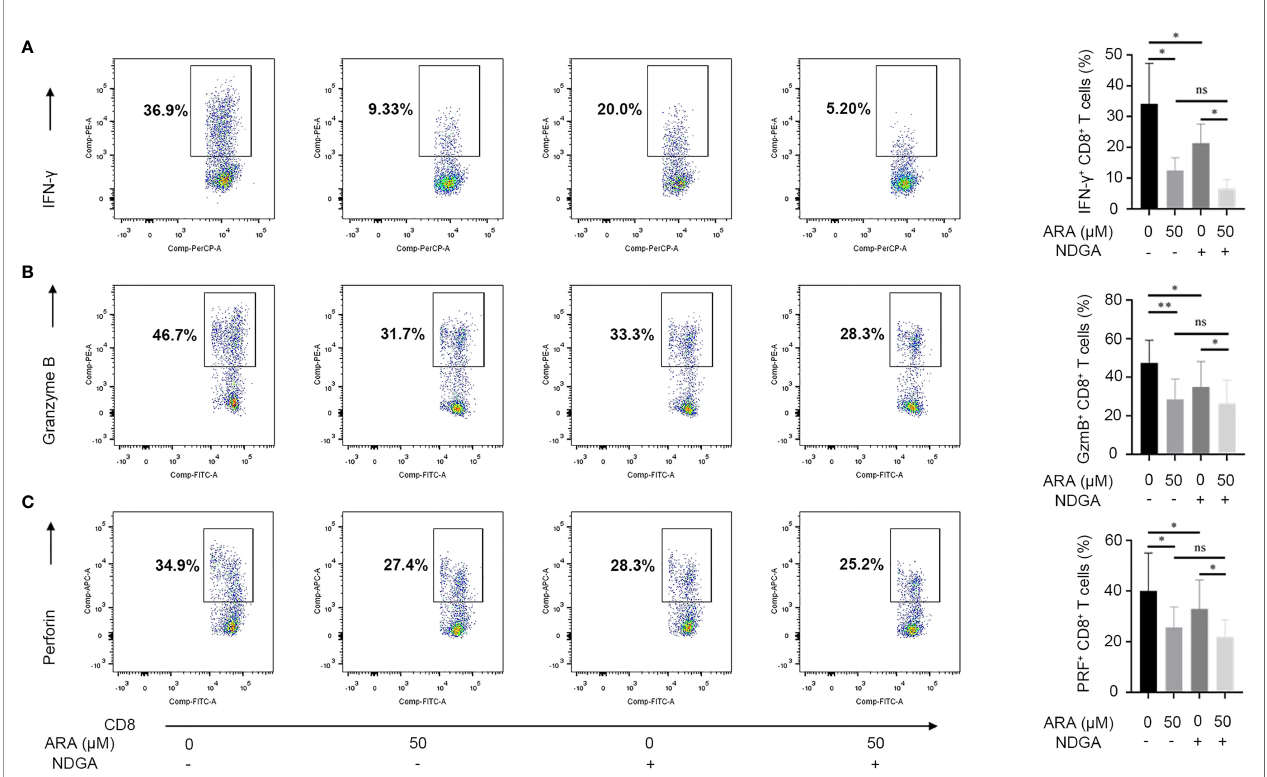
FIGURE 6 | ARA and NDGA inhibit effector functions of CD8 + T cells. Vitiligo PBMCs were stimulated with anti-CD3/CD28 for 48 hours in different conditions (with or without NDGA (10 m M) in the presence or absence of ARA (50 m M)) for 48 h. Expression of IFN- g (A) , Granzyme B (B) , and Perforin (C) in CD8 + T cells was determined by fl ow cytometry (n = 6). ARA, arachidonic acid; NDGA, nordihydroguaiaretic acid; m M, m mol/l; ns, no signi fi cance, * P < 0.05, ** P <